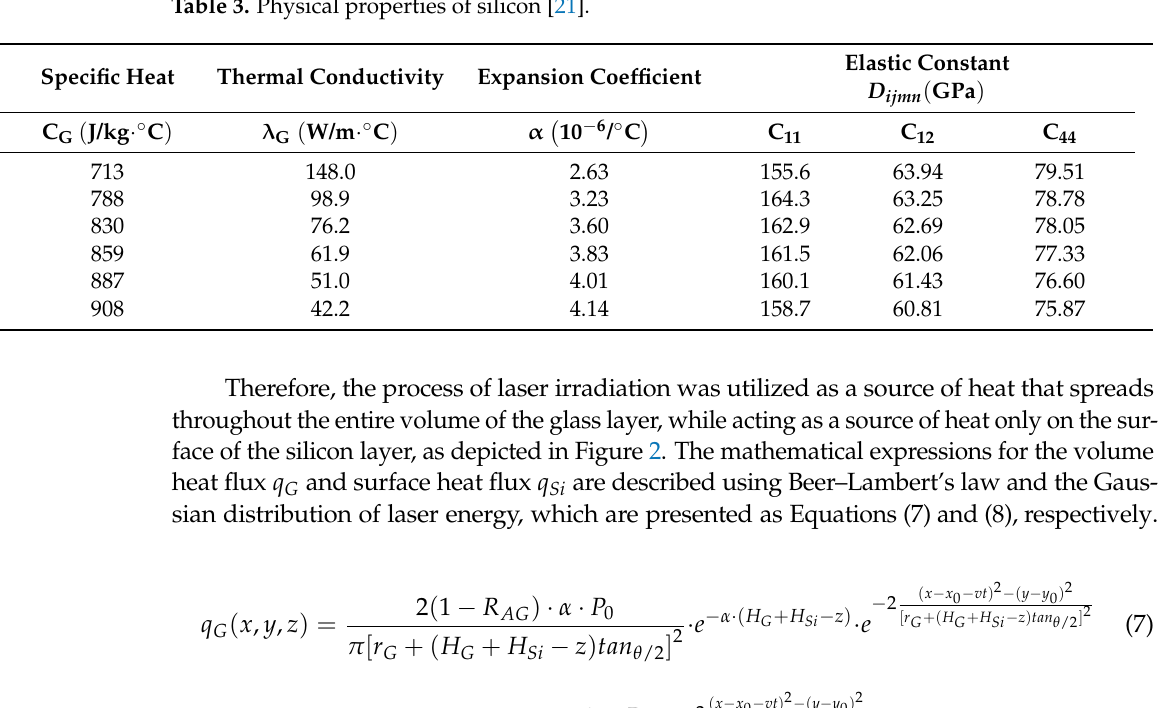
Table 3. Physical properties of silicon